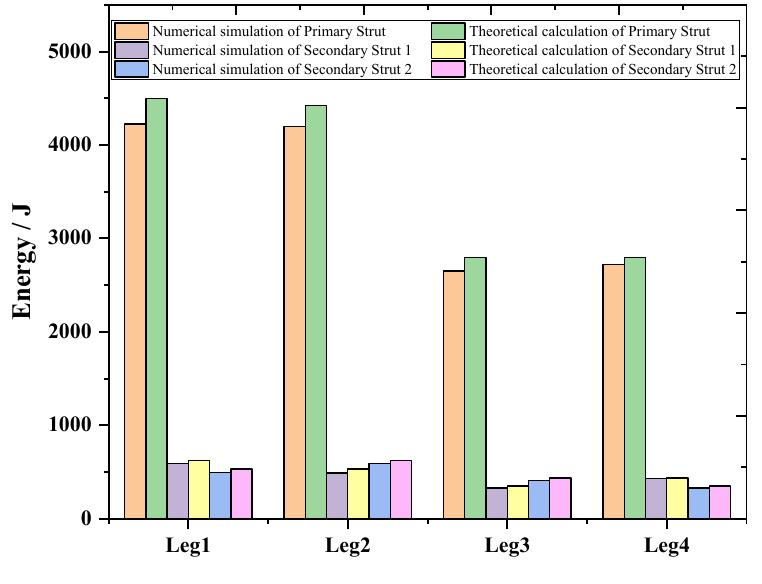
Figure 20. EA of 2-2 type landing.